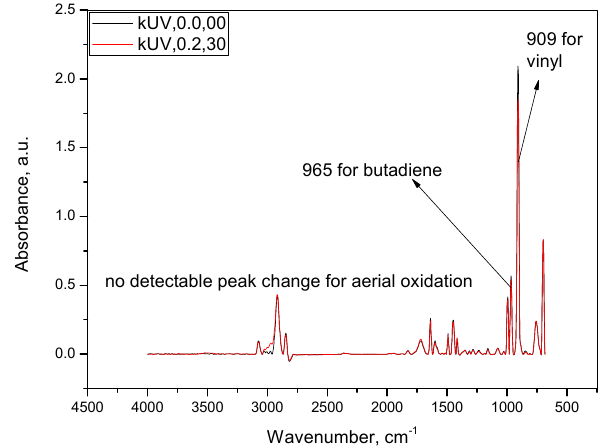
Figure 10. Superimposed, baseline subtracted spectra of the control sample and 0.2 phr incorporated 30 s irradiated sample to study oxidation of the UV-irradiated sample.